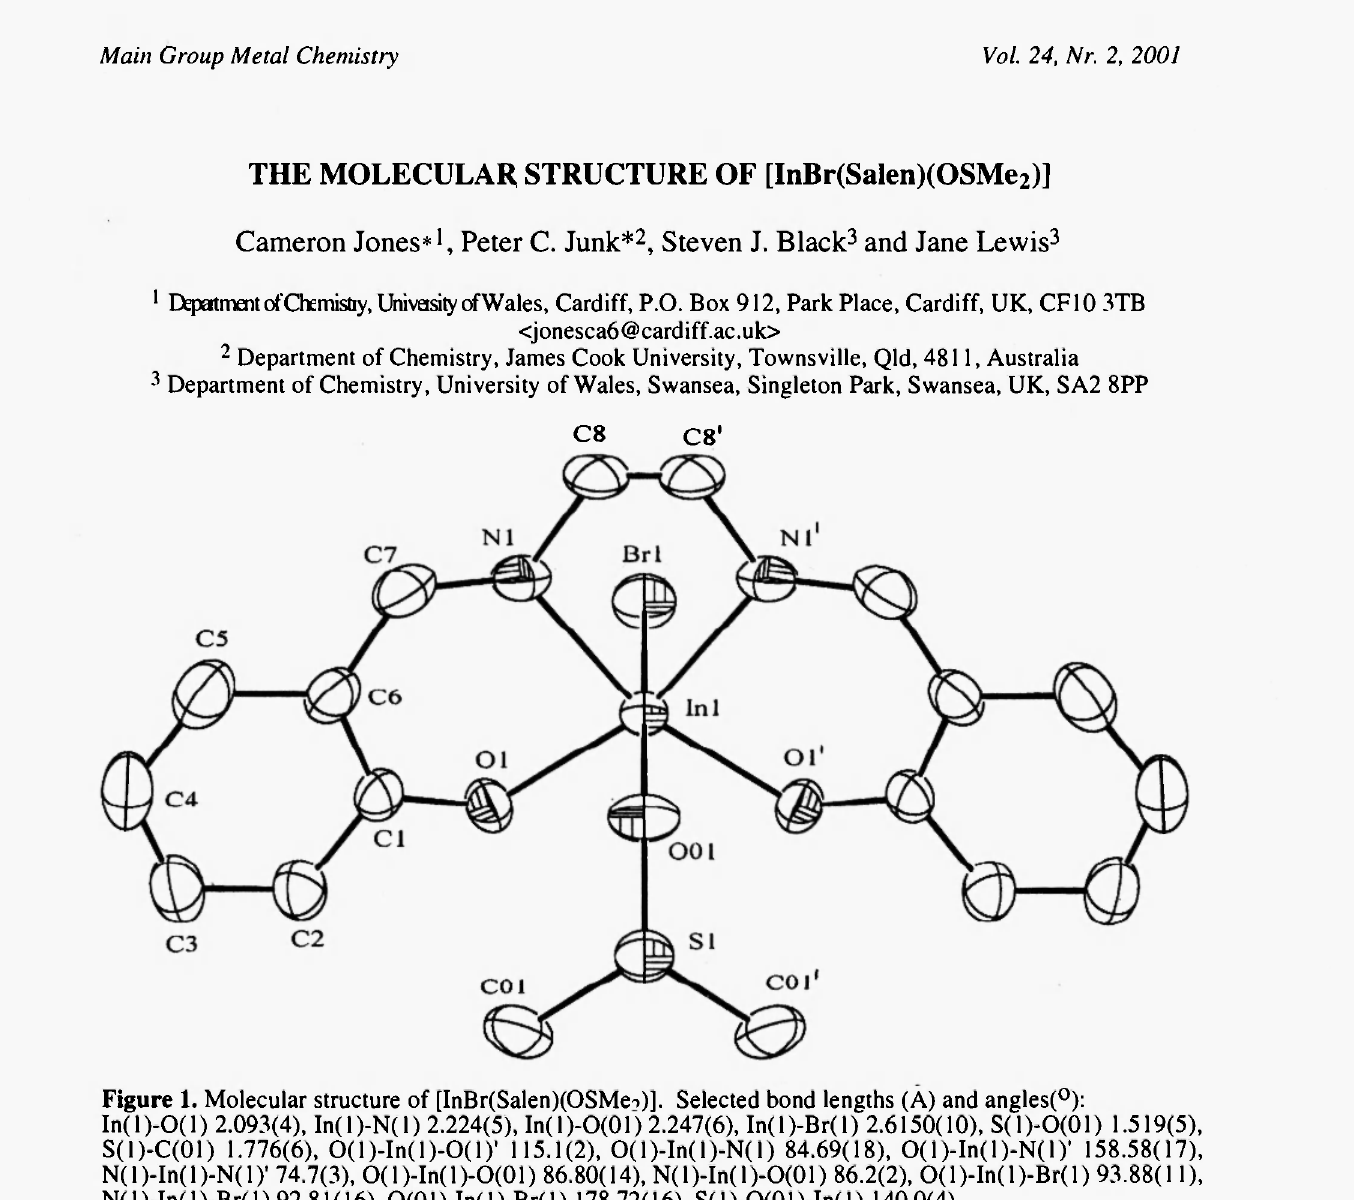
Figure 1. Molecular structure of [InBr(Salen)(OSMe->)]. Selected bond lengths (A) and angles(°): In(l)-0(1) 2.093(4), In(l)-N(l) 2.224(5), In(l)-0(01) 2.247(6), In(l)-Br(l) 2.6150(10), S(l)-0(01) 1.519(5), S(l)-C(01) 1.776(6), 0( 1 )-In( 1 )-0( 1)' 115.1(2), 0(1)-In(l)-N(l) 84.69(18), 0(1)-In(l)-N(l)' 158.58(17), N(l)-In(l)-N(l)' 74.7(3), 0(l)-In(l)-0(01) 86.80(14), N(l)-In(l)-0(01) 86.2(2), 0(1)-In(l)-Br(l) 93.88(11), N( 1 )-In( 1 )-Br( 1) 92.81 (16), 0(01 )-In( 1 )-Br( 1) 178.72( 16), S( 1 )-0(01 )-In( 1) 140.0(4). Comment The molecule was found to be monomeric and to sit on a mirror plane containing the atoms S(l), 0(01), In(l) and Br(l). The atom C(8) was found to be disordered over two sites [C(8) and C(8')] and the disorder was successfully modelled. The coordination environment about In(l) is distorted octahedral, with the atoms 0(01) and Br(l) trans- to one another. Interestingly the S(l)-0(01)-In(l) angle of 140.0(4)° is considerably more open than in any previous complex containing a dimethylsulfoxide coordinated indium centre in which such angles normally lie between 120-125°, e.g. 124.18° avge. in [InCljiOSM^)}] [1]. Experimental Preparation of [InB>iSalen)(OSMe2)]: A solution of InBr^ (1.60g, 4.5 mmol) in methanol (75 ml) was added to a refluxing solution of SalenfL· (1.20g, 4.5 mmol) in methanol. The resulting yellow solution was treated with aqueous NaOH (2M, 5 ml) yielding an immediate yellow precipitate. This was filtered off, washed with methanol (3 χ 20ml) and dried in vacuo. The product was recrystallized from dimethylsulfoxide to give yellow crystals (1.80g, 67% yield), m.p. 262°C (dec.), Ή NMR (250MHz, D 6 -DMSO) δ 8.56 (2H, s, HC=N), 7.29-7.34 (4H, m, Ar), 6.65-6.79 (4H, m, Ar), 3.90 (4H, br. s, NCH 7 ), 2.62 (6H, s, CH 3 ); ,3 C NMR (100.6 MHz, D 6 -DMSO) δ 170.1 (HC=N), 169.2, 136.3, 134.1, 123.8, 119.0,Ί 16.3 (Ar), 54.5 (NCH 2 ), 39.3 (Me); IR (Nujol) v/cnr 1 1649(s), 1530(s), 1052(s); MS: m/z 269 (SalenH + , 100%), 382 (Salenln*, 20%), 463 (SalenInBr + ,